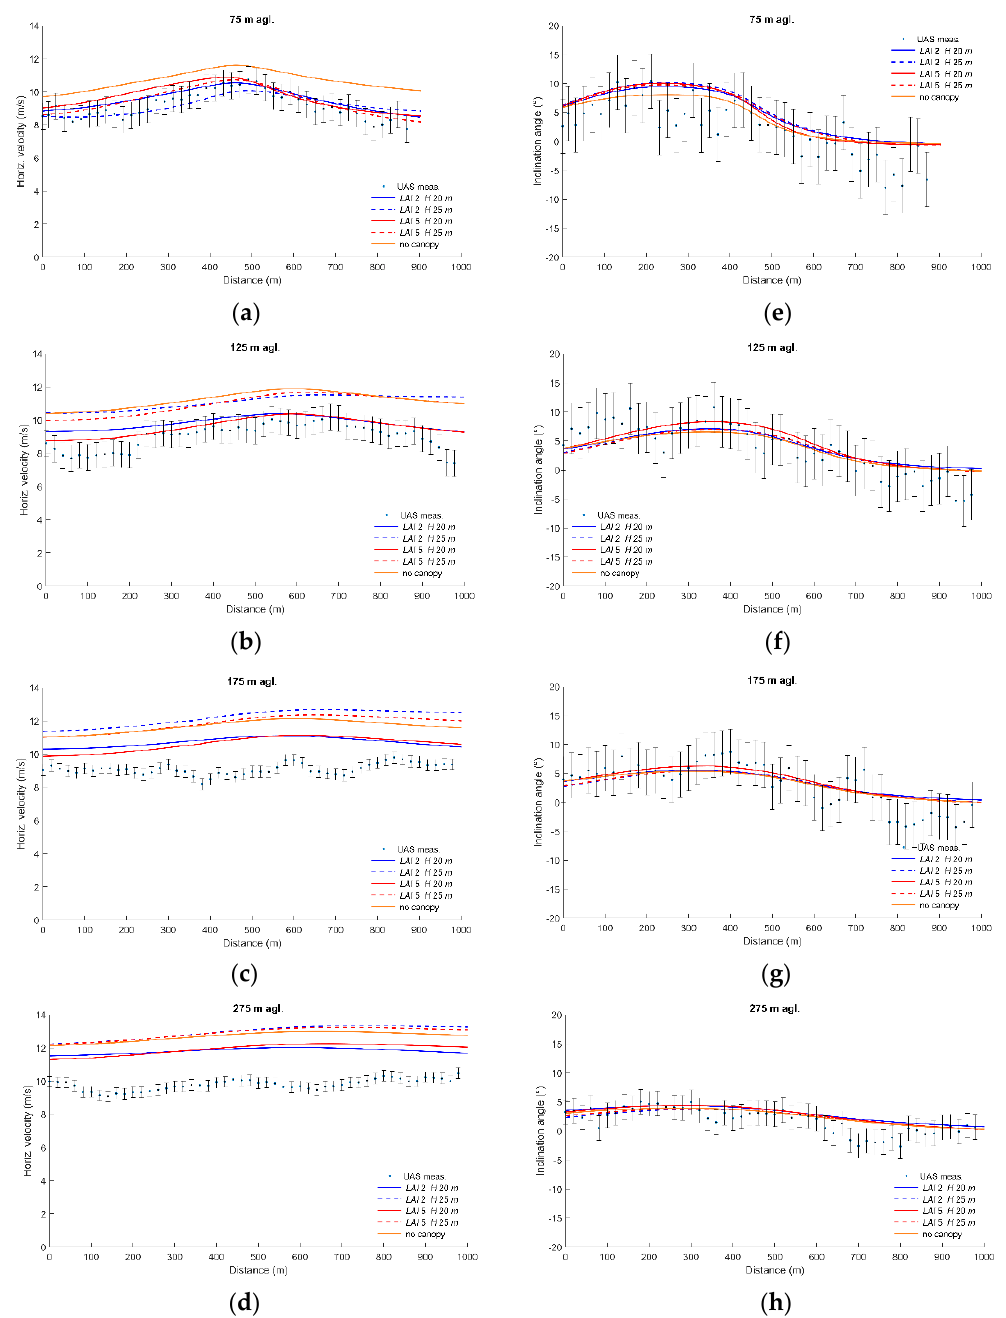
to Figures 14 and 15.